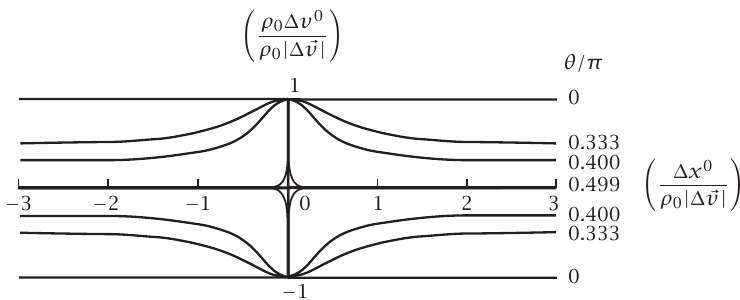
Figure 4.3 . Causal boundary equation (4.17): (ρ function of ( ∆ x 0 /ρ 0 | ∆ (cid:11)v | ) for various values of the angle θ between the spatial component ∆ (cid:11)v of relative four-velocity and the spatial- separation vector ∆ (cid:11)x